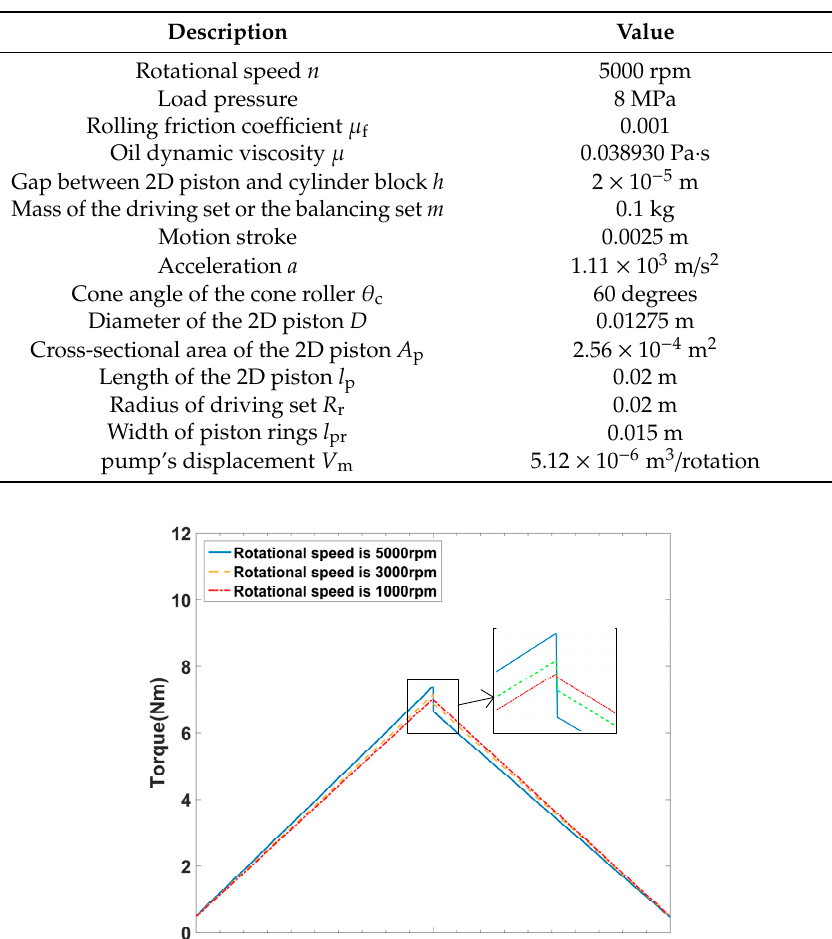
Table 1. Parameters of the mathematical model.